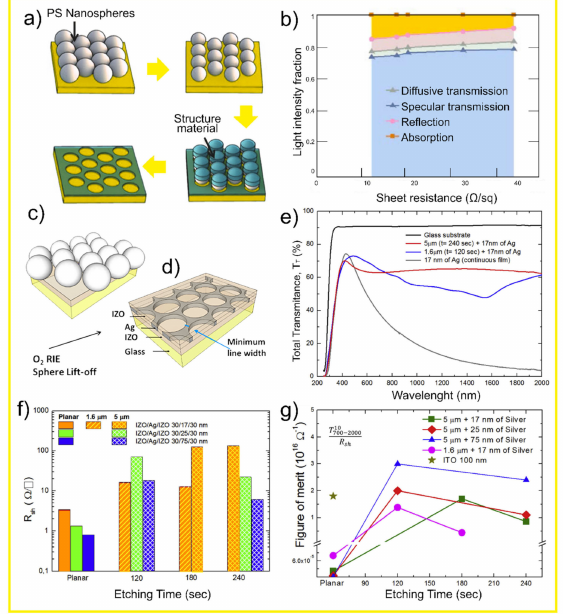
Figure 16. ( a ) Schematic of the Cu MME fabrication process by CL. ( b ) Plot of the measured diffuse transmission, specular transmission, reflection, and absorption at λ = 550 nm versus sheet resistance for a variety of Cu MMEs on quartz. Adapted with permission from [172]. Copyright 2021 American Chemical Society. ( c , d ) Schematic of the CL fabrication of Ag MMEs, showing the initially deposited PS sphere mask ( c ) and the final structure of the IZO/Ag grid/IZO electrode ( d ), in which the top and bottom IZO layers are ultrathin (30 nm). ( e ) Transmittance of samples with 17 nm thick Ag grids (blue and red lines), produced with distinct sphere size and etching time, compared to a continuous Ag film (grey line)—high transparency can be noted in the NIR region. ( f ) Sheet resistance of the electrodes fabricated with different diameters of PS spheres (1.6 or 5 µ m), etching time, and Ag thickness. ( g ) Haacke’s figure-of-merit (expression in inset) for the main MMEs attained in this work, in comparison with a state-of-the-art TCO film made of ITO and with continuous (planar) Ag layers. Adapted with permission from [62]. Copyright 2021